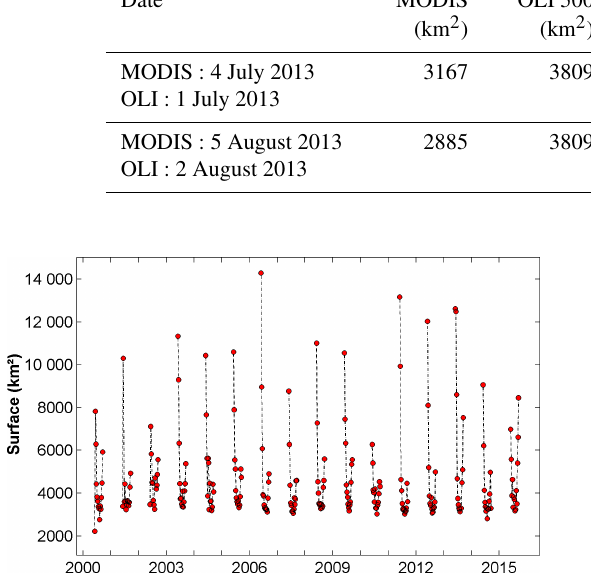
Figure 4. Time series of surface water extent from 2000 to 2015, between June and September, derived from the MODIS images.